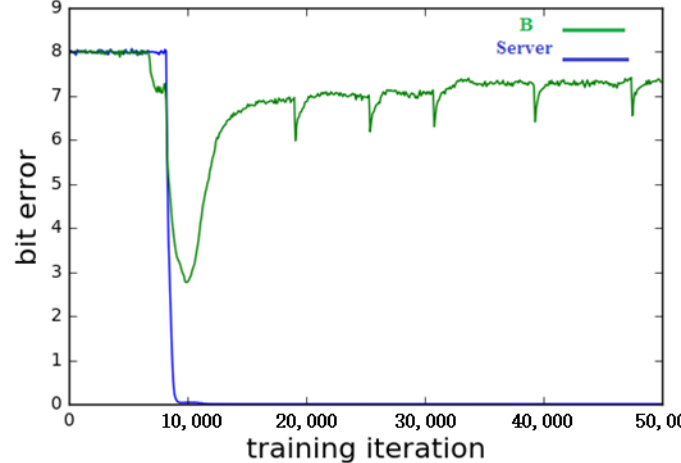
Figure 7. Evolution of the reconstruction errors of Server and B during training.